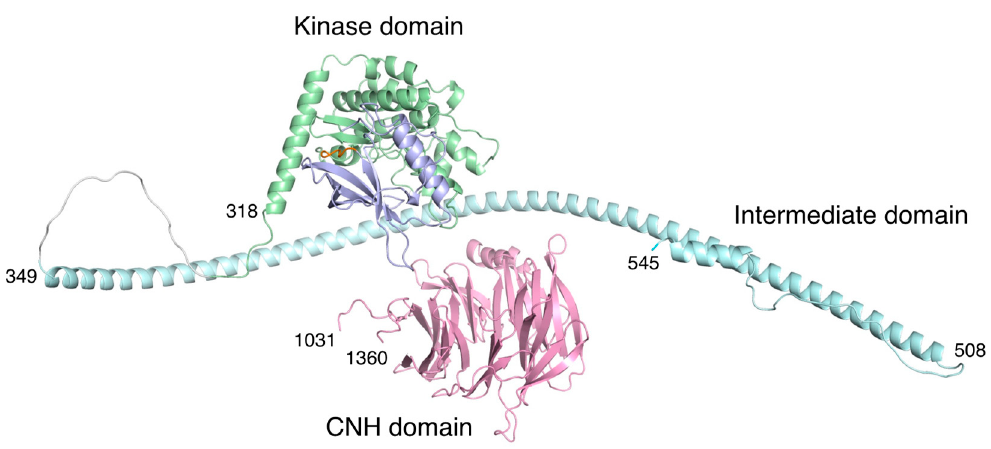
Figure 6. Structural model of human TNIK by AlphaFold prediction [34]. The color coding of the domains is the same as in Figure 1. The approximately 500-residue unstructured region (residues 546-1030) in the intermediate domain was omitted for clarity. Due to the unstructured regions flanking the three domains, the arrangement of each domain is expected to be flexible.